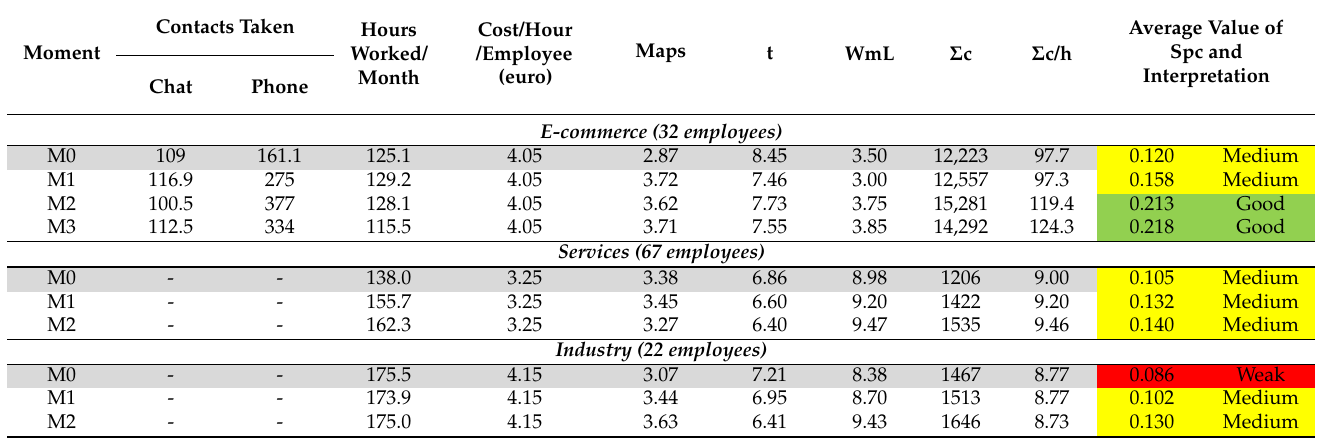
Table 3. Average values for the elements of the Spc indicator before and after implementation.